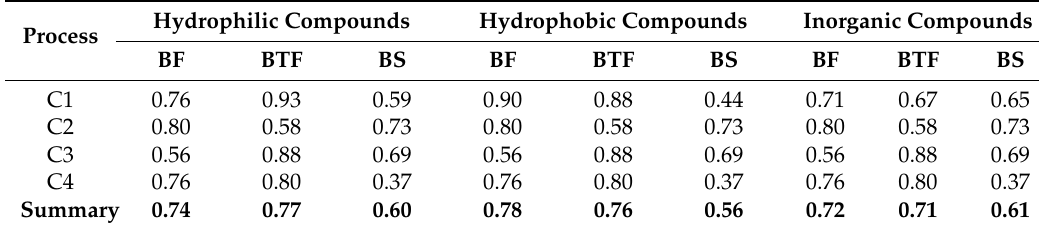
Table 4. Scores of the alternatives for each